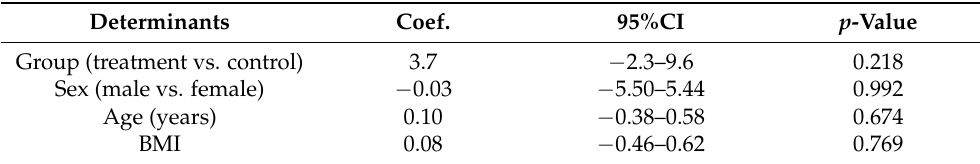
Table 7. Analysis of the determinants of the difference between KOOS T1 and KOOS T0 in a multivariate linear regression model. Coef. 95%CI p -Value Group (treatment vs.